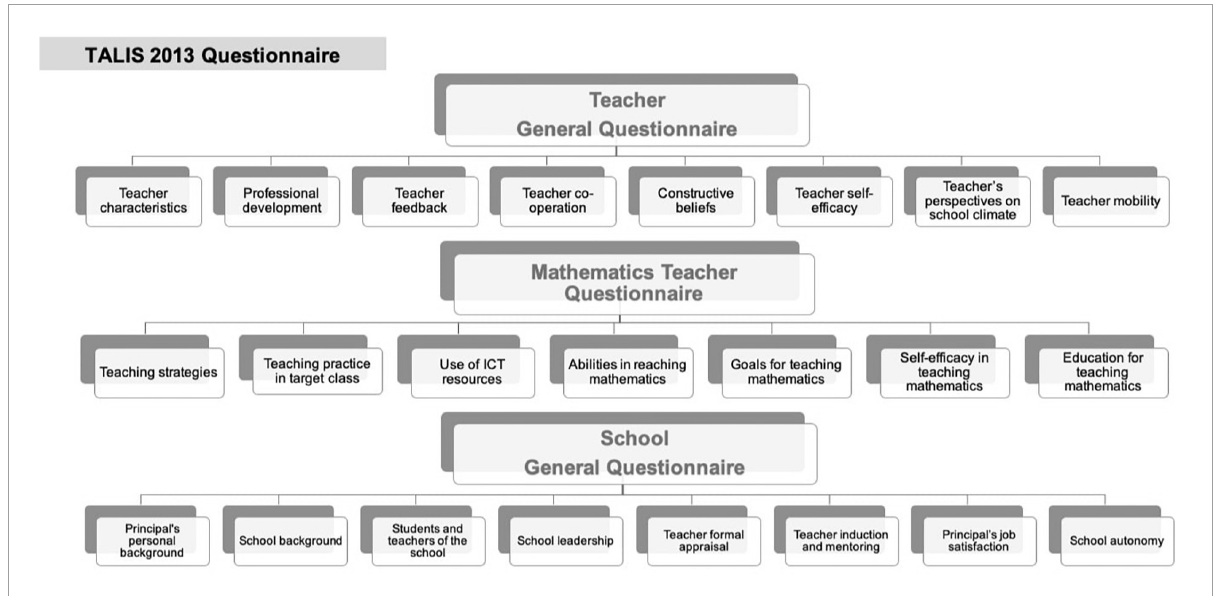
FIGURE2 The main aspects of the teacher and school questionnaire in teaching and learning international survey